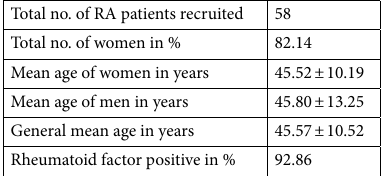
Table 1. Demographic details of RA